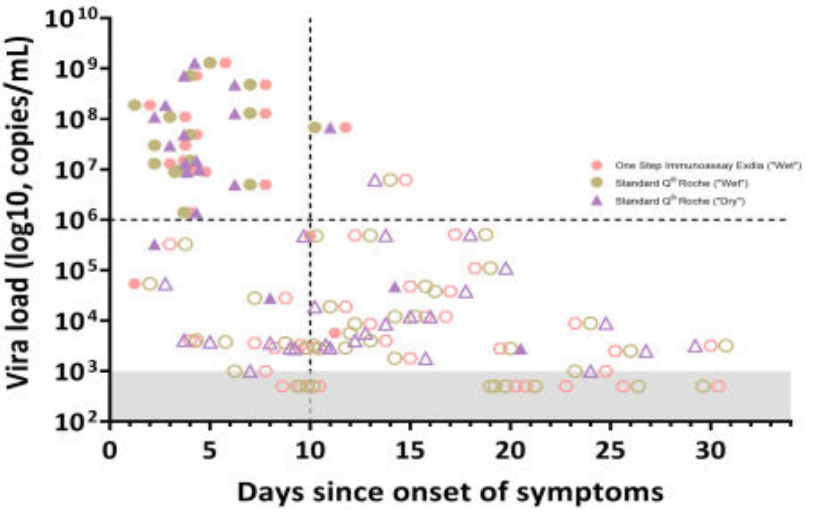
Figure 4. Rapid antigen test results according to time since onset of symptoms and viral load. Full shaded symbols show positive results while no shaded symbols show negative RAT